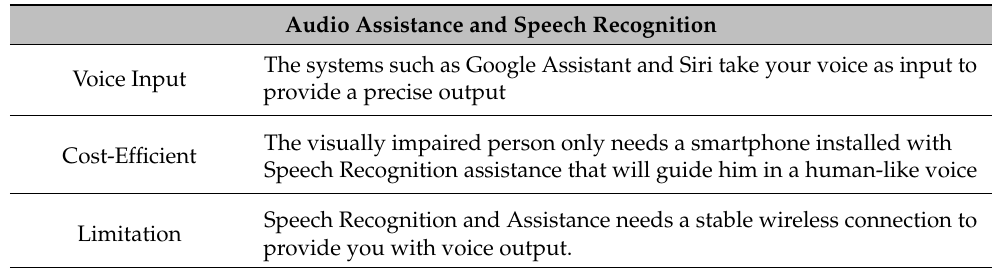
Table 4. Summary of Various Audio-Assisted and Speech Recognition-Based Navigation